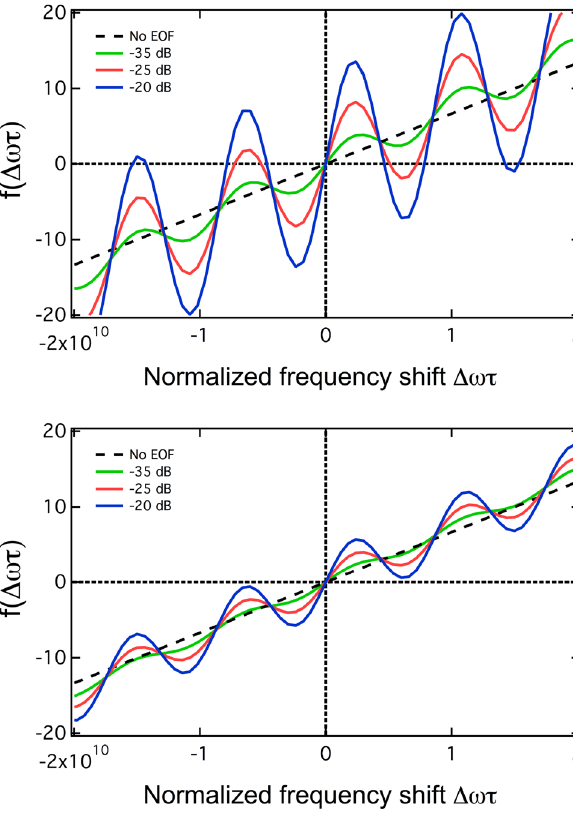
Figure 9: Number of solutions for (a) the QW laser with α H = 4, and for (b) the epitaxial QD laser with α H = 1 and. In both cases, the EOF strength r ext is fi xed to − 35 dB (green), − 25 dB (red), and − 20 dB (blue). The black dashed line corresponds to the case without EOF ( r ext =0). The external cavity length is fi xed to 10